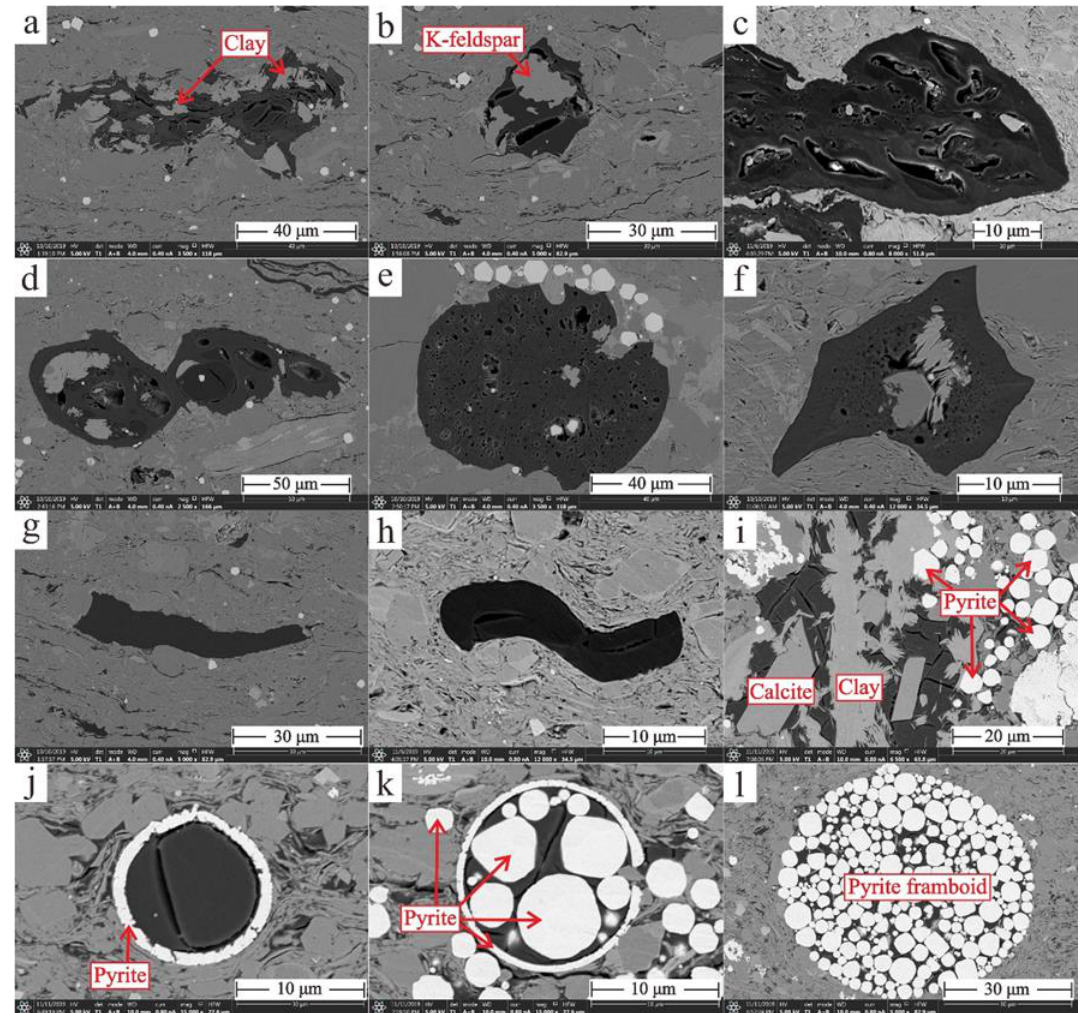
Figure 2. FE-SEM images of organic-matter pores. ( a ) SK1S16, mudstone; ( b ) SK1S16, mudstone; ( c ) SK1S32, mudstone; ( d ) SK1S16, mudstone; ( e ) SK1S16, mudstone; ( f ) SK1S38, mudstone; ( g ) SK1S16, mudstone; ( h ) SK1S32, mudstone; ( i ) SK1S36, mudstone; ( j ) SK1S36, mudstone; ( k ) SK1S36, mudstone; and ( l ) SK1S36, mudstone.